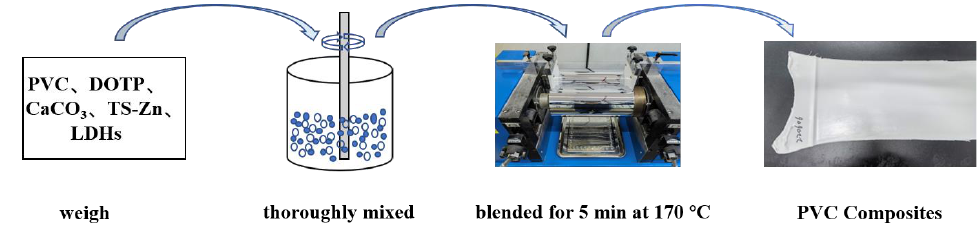
Figure 1. A schematic diagram of the preparation of PVC composites.